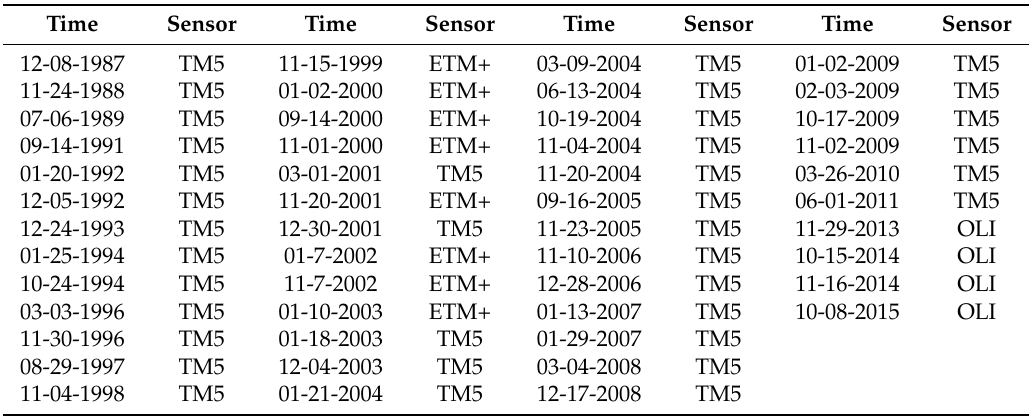
Table 1. Acquisition dates of remote sensing